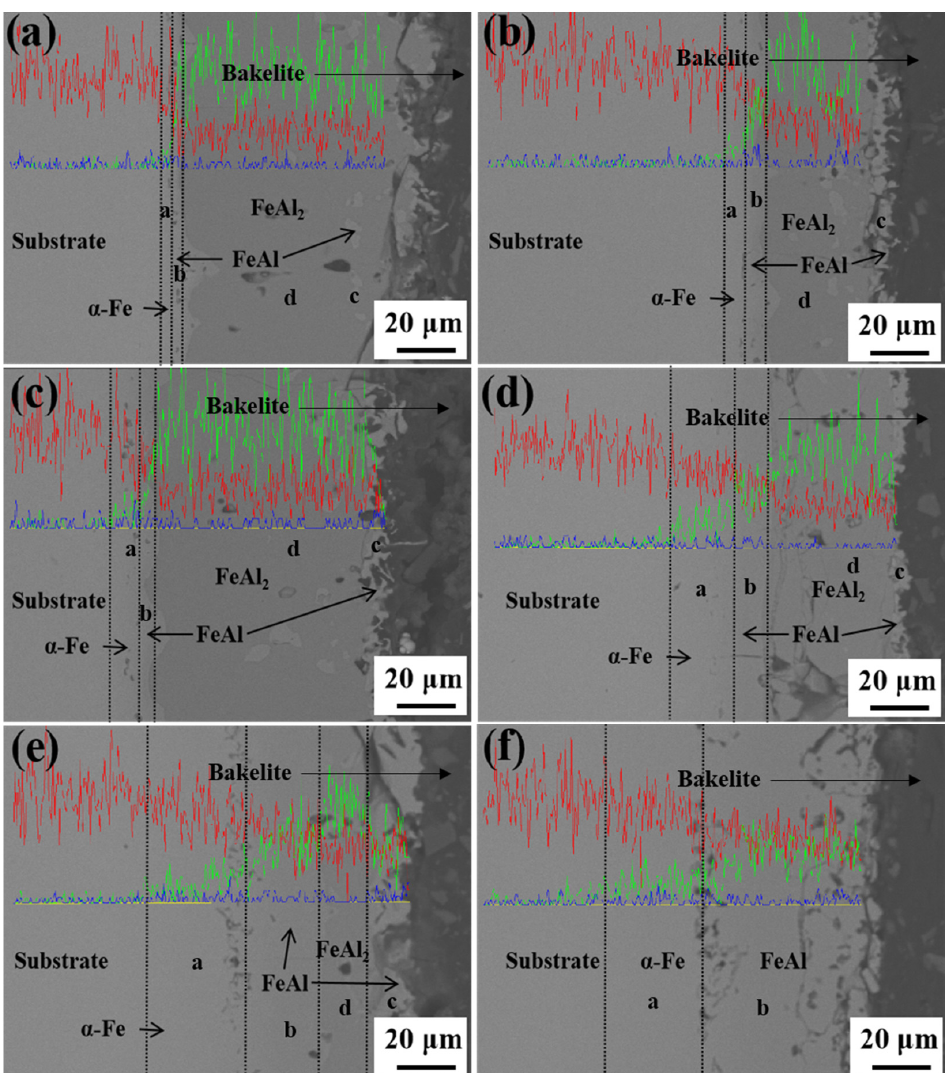
Figure 5. Cross-sectional microstructure of Q345 after hot dipping in Al-2.5Si solution and annealed at 800 °C or 900 °C for different times, and its corresponding EDS line profiles of elements Fe (red line), Al (green line), and Si (blue line) distributions across the coating layer on the steel substrate. ( a ) at 800 °C for 1 h, ( b ) at 800 °C for 22 h, ( c ) at 800 °C for 3 h, ( d ) at 900 °C for 1 h, ( e ) at 900 °C for 2 h, ( f ) at 900 °C for 3 h.